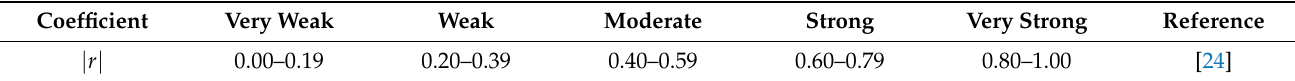
Table 3. Interpretation of the correlation coefficient ( | r | )